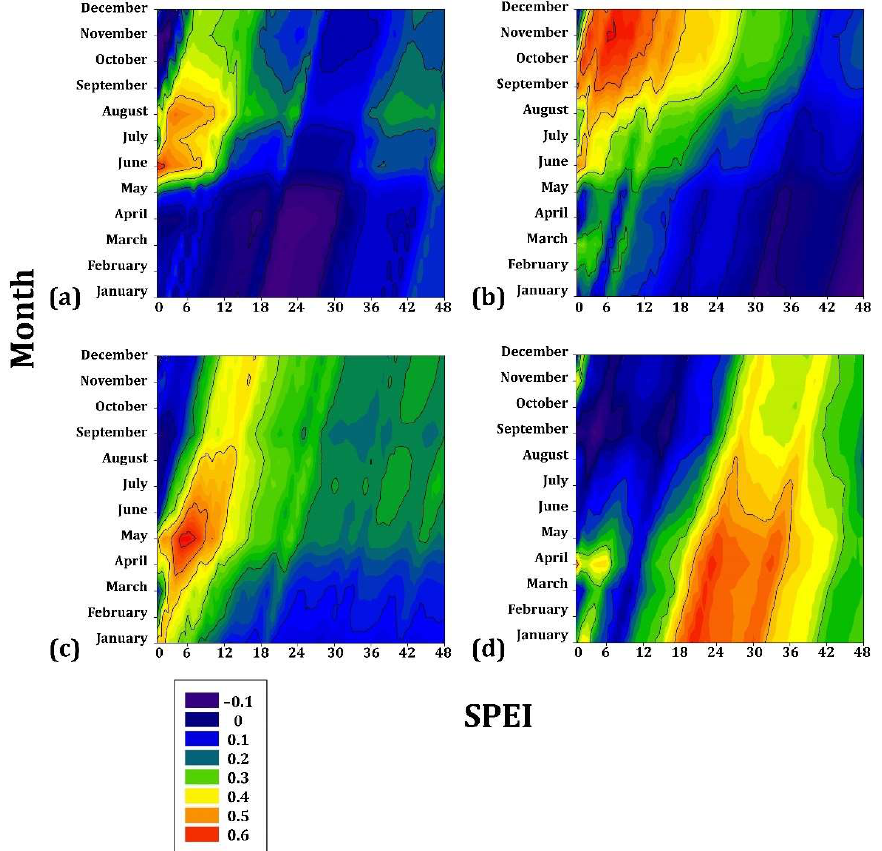
Figure 6. Drought–growth associations calculated for four Mexican conifer species (>3000 m asl) by relating the SPEI drought index to the residual growth–ring width chronologies. The SPEI was calculated in scales of 1 to 48 months ( x axes) from JAN to DEC in the current year of growth ( y axes). ( a ) Abies hickelii ; ( b ) Juniperus deppeana ; ( c ) Abies religiosa ; ( d ) Pinus hartwegii. The Pearson correlation coefficients (r) are indicated using color scales.